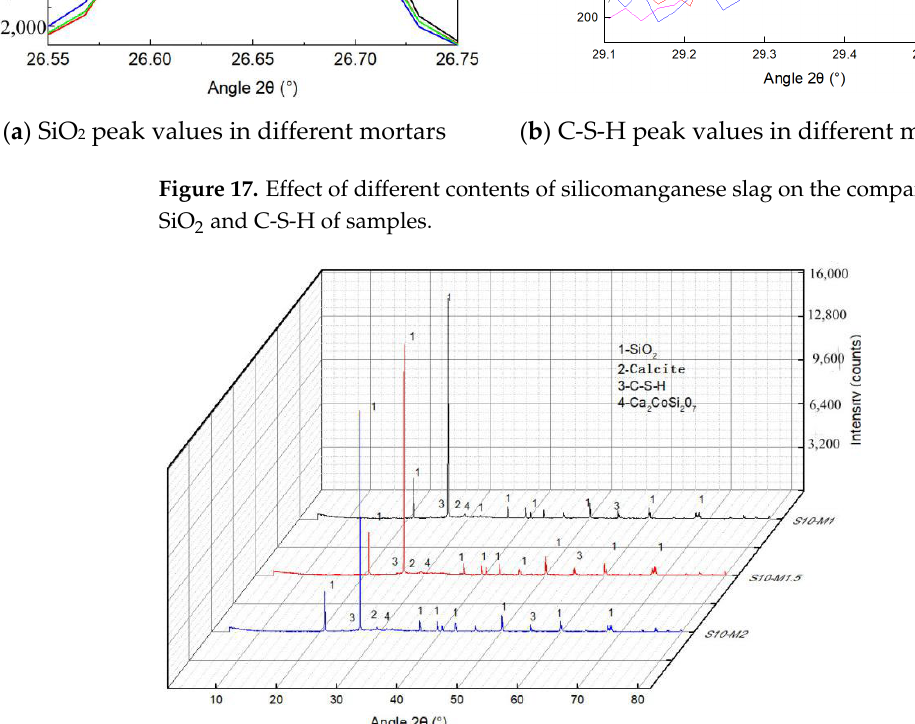
Figure 18. XRD patterns of AASSC with different modulus.